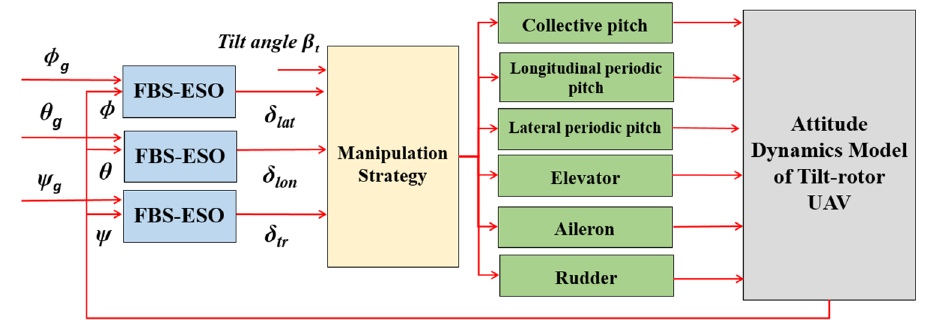
Figure 4. Attitude control system of the tilt ‐ rotor UAV.